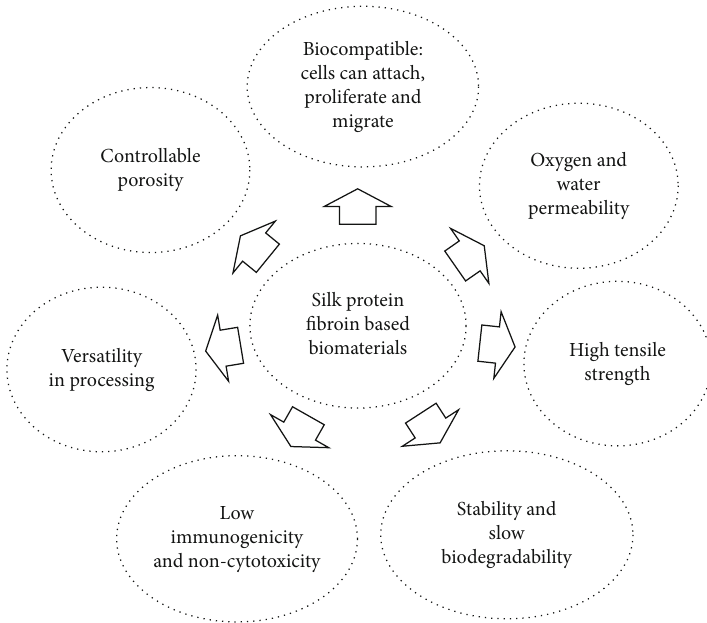
Figure 2: Diverse characteristics of biomaterials based on silk protein fi broin (adopted from Naskat et al. [40]).